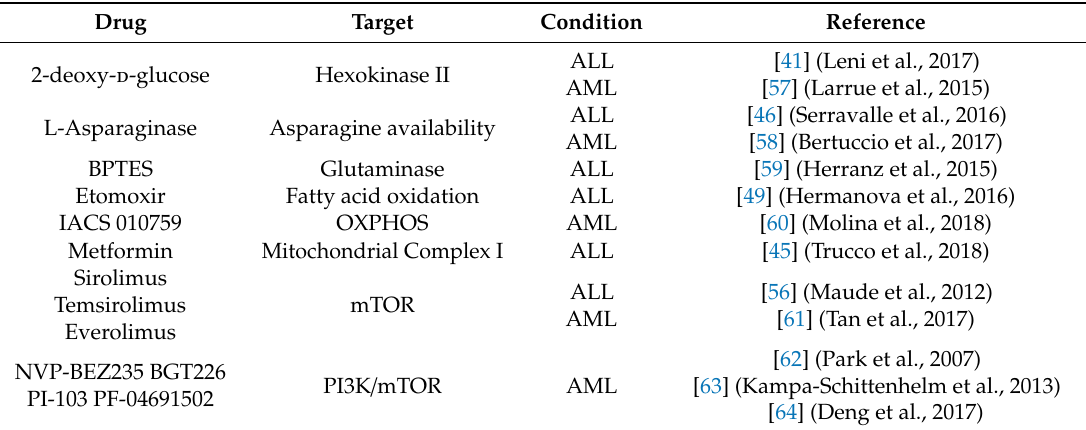
Table 1. Summary of metabolic-based therapeutic drugs to be exploited in pediatric leukemia, including both compounds that directly target metabolic enzymes together with signaling cascade inhibitors that are involved in cell metabolism and its